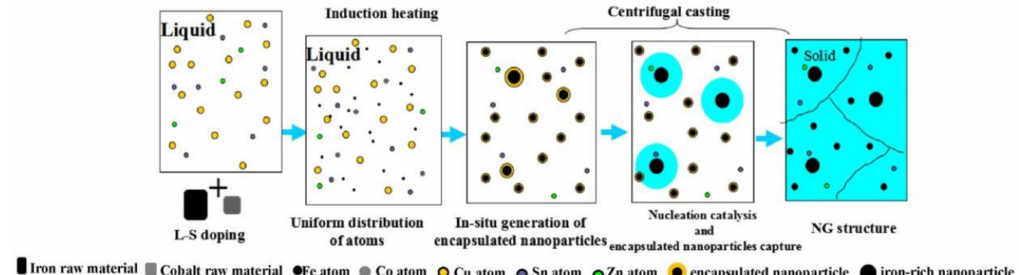
Figure 7. NPFG structure in-situ formed in cast Cu-10Sn-2Zn-1.5Fe-0.5Co (wt. %) alloy [64]. Large amounts of iron-rich particles in-situ form in the melt at first, which can absorb Cu atoms in the melt. During the solidification process, a small part of nanoparticles can serve as nucleation cores and most particles are captured by the solid/liquid interface. Resultantly, typical NPFG structure is observed in as-cast ingots.